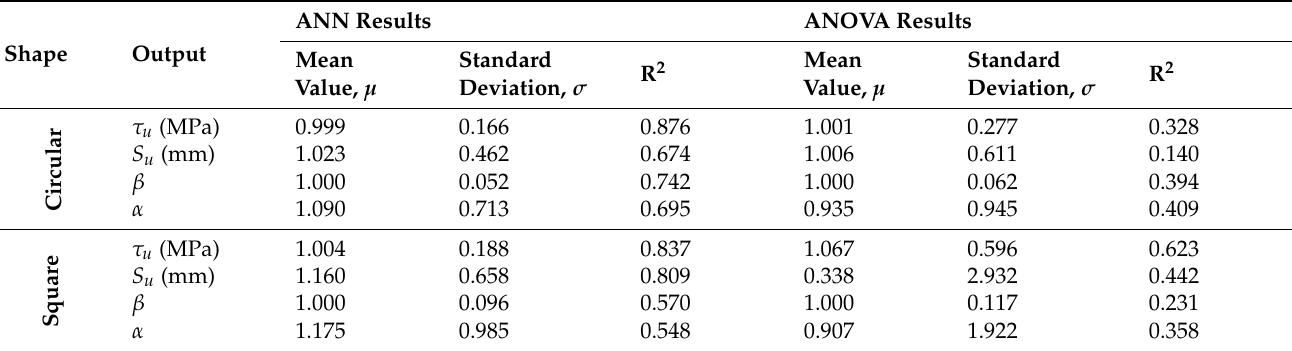
Table 1. Comparison between mean value, standard deviation, and R 2 of the ratio of experimental values to estimated values using the proposed ANOVA and